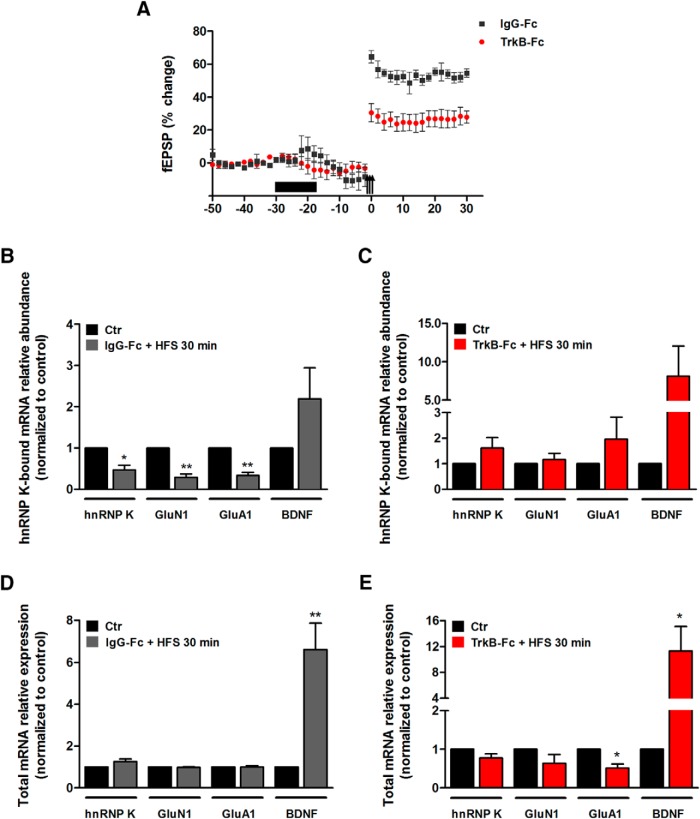
BDNF signaling is required for LTP maintenance and LTP-induced alterations in mRNA interaction with hnRNP K. A, Time-course plots showing changes in the medial perforant path-evoked fEPSP in rats receiving TrkB-Fc (1 μl, 100 μg) or IgG-Fc (1 μl, 100 μg) infusion before HFS (arrows). Values are means ± SEM and are expressed in percentage of the baseline. Test pulses were applied at 0.033 Hz. HFS was applied in three series of 400-Hz bursts separated by 5 min. TrkB-Fc (1 μl, 100 μg; n = 6) or IgG-Fc (1 μl, 100 μg; n = 6) were infused in the dorsal DG at 0.08 μl/min during the period indicated by the black bar. Test pulses were not given during the HFS period. B, C, The levels of hnRNP K, GluN1, GluA1, and BDNF mRNAs coimmunoprecipitated with hnRNP K were assayed by qPCR in DG homogenates obtained from (B) IgG-Fc (n = 6) and (C) TrkB-Fc (n = 6) infused rats at 30-min post-HFS. Results are presented as mean ± SEM normalized to the correspondent contralateral DG. D, E, The variation of total hnRNP K, GluN1, GluA1, and BDNF mRNA levels in (D) IgG-Fc (n = 6) and (E) TrkB-Fc (n = 6) infused rats was assayed by qPCR in DG homogenates obtained at 30-min post-HFS. Results are presented as mean ± SEM normalized to the correspondent contralateral nonstimulated DG, and Hprt1 was used as internal control gene; *p < 0.05; **p < 0.01, as determined by the paired Student’s t test.